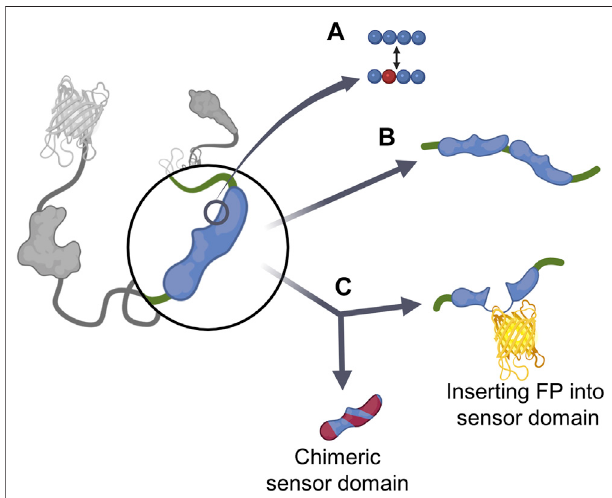
FIGURE 2 | Existing cases of sensor domain optimization strategies (A) Mutagenesis. (B) Additional sensor domain. (C) Reconstituting sensor domain, which is divided into chimeric sensor domain and inserting FP into sensor domain.